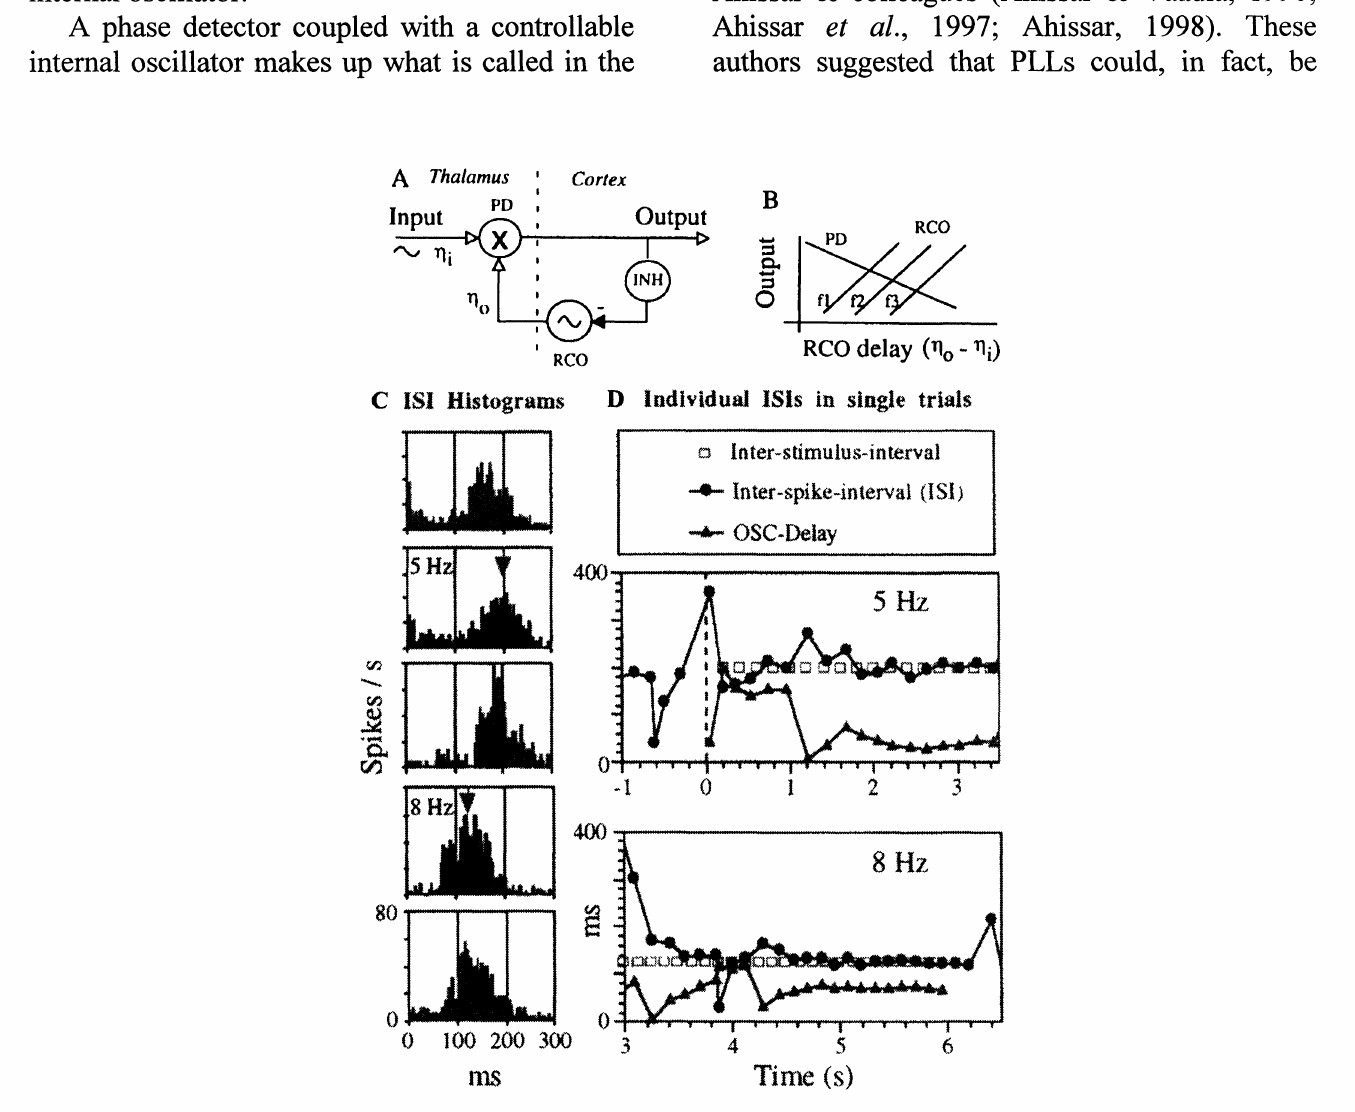
Fig. 4: (A) Principles of an inhibitory Phase-Locked Loop (PLL) decoder. INH, inhibitory neurone(s); RCO, inhibitory connection; rl0, time of the recent RCO spike; rli, time of the recent input spike; PD, phase detector. B" PLL transfer functions. The transfer functions should be monotonic, but not necessarily linear, within the PLL’s working ranges. The PD’s output decreases as the RCO delay (rl0-rli) increases (PD curve). The RCO’s firing time is delayed as the PD’s output is increased (RCO curves). The exact relation between the two transfer functions depends on the input frequency (fl > f2 > f3); stable (crossing) working points for higher frequencies are associated with larger RCO delays and lower outputs. (C, D): Frequency locking of a single-cell cortical oscillator recorded from layers 2-3 of the barrel cortex of an anaesthetized rat during the stimulation of whisker E2 with square-wave stimuli. (C): Interspike intervals (ISI) computed during the entire stimulation periods (black) and the interleaved spontaneous periods (gray). Arrows point to the interstimulus intervals. (D): Lock-in dynamics during single stimulus trains. ISis, inter-stimulus intervals and OSC-delays (triangles) are plotted as a function of time. Time 0 and the dashed line denote the beginning of a stimulus train. Note the 1:1 firing (one OSC spike per stimulus cycle) and constant phase difference during stabilized states. In the trial presented at bottom, the OSC remained "locked" for two additional cycles after the stimulus train ended. (From Ahissar et al, 1997). Reprinted with permission. (C) 1997 National Academy of Sciences,